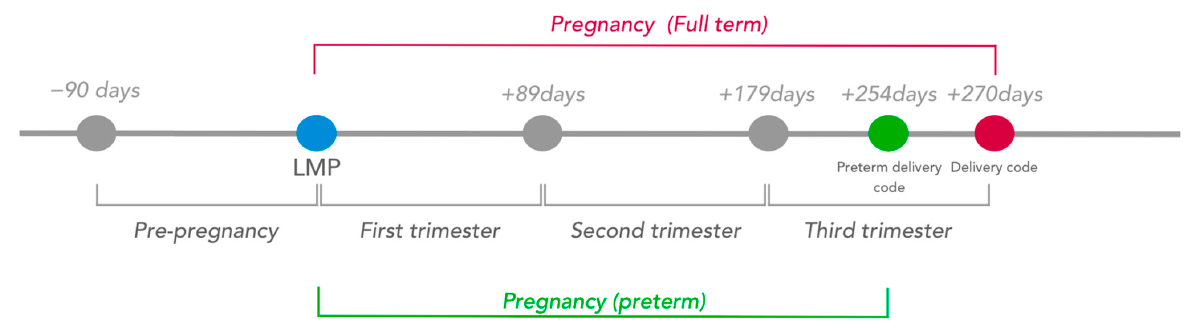
Figure 2. Estimation of the last menstrual period and pregnancy periods.